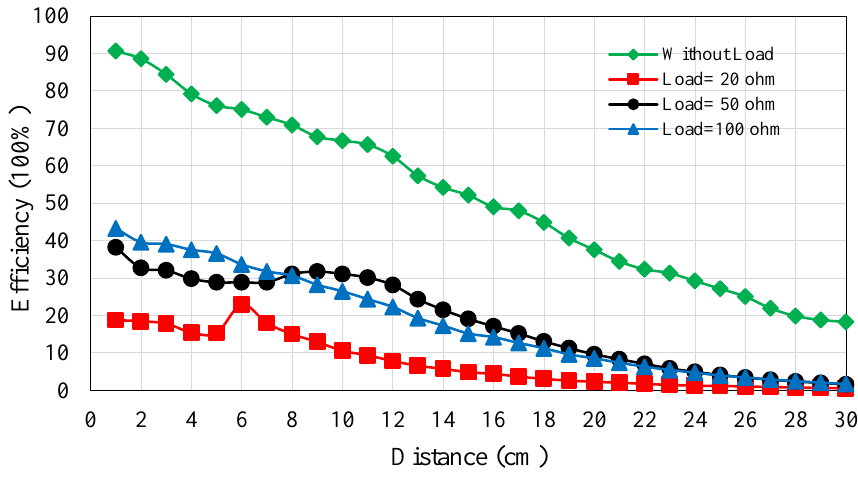
Figure 15. The relationship between transfer efficiency and transfer distance, with and without load.